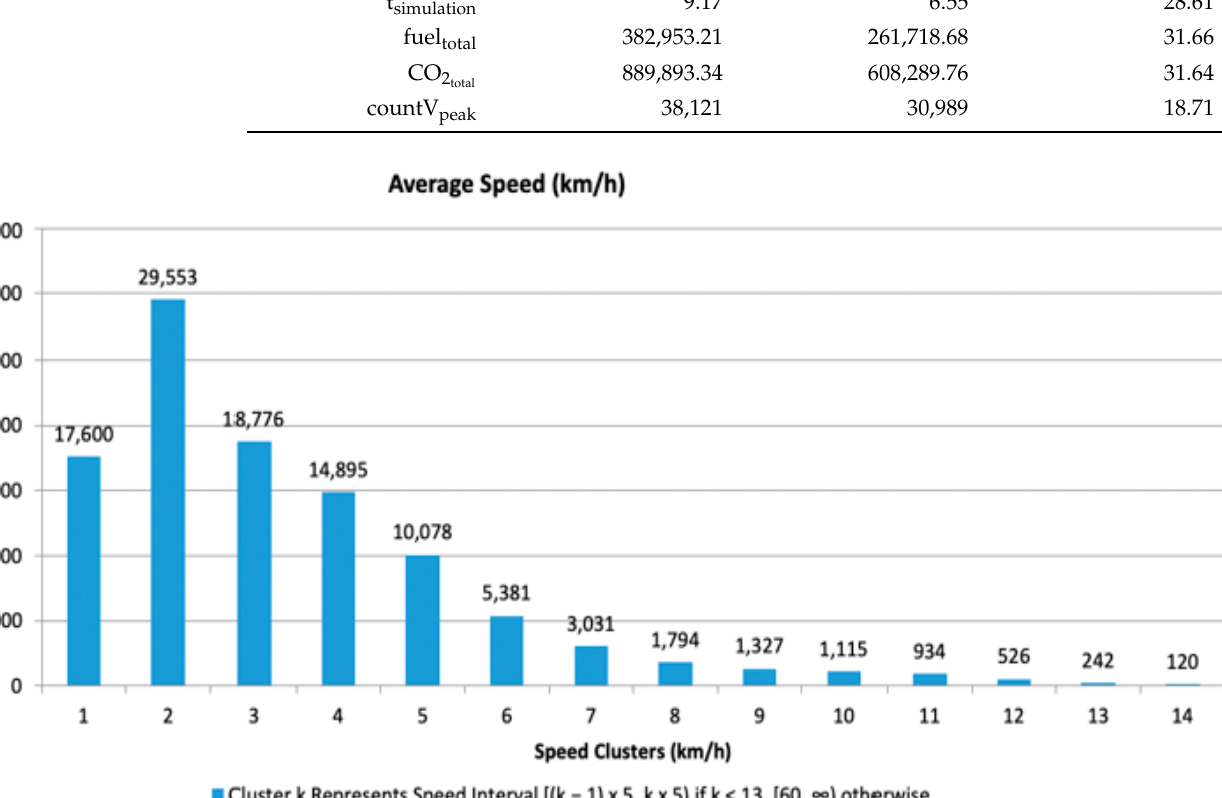
Figure 9. Speed distribution in clusters for 100 K+ simulated vehicles in Barcelona with δ =